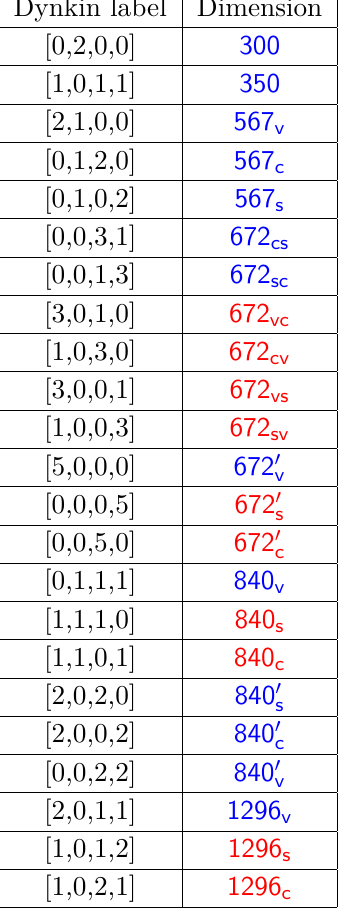
Table 5 . so (8) irreducible representations #2